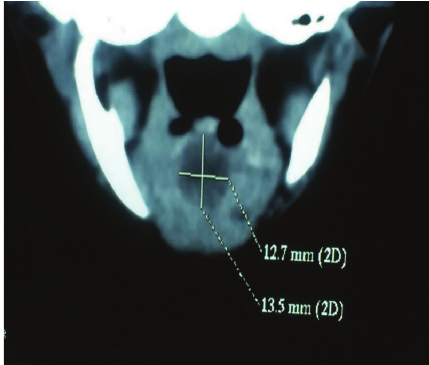
Figure 5: Contrast enhanced computed tomographic scan showing nonenhancing cystic lesion located at the base of the tongue measuring 12.7mm × 13.5